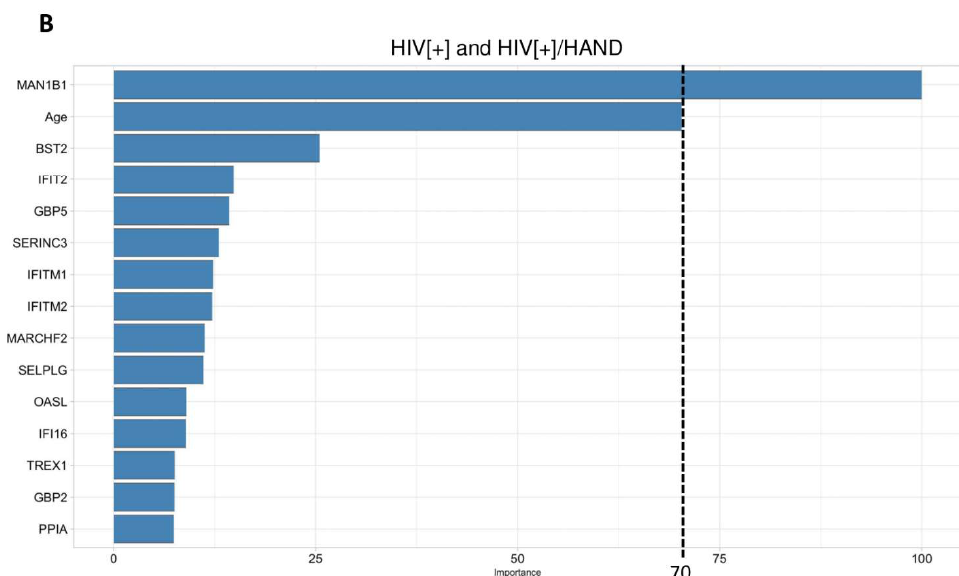
Figure 7. Analyses of variables predicting clinical group classification by machine learning. The regularized logistic regression machine learning method was used to predict variables that distin- guished the HIV[+] group from the HIV[−] group ( A ). Shrinkage discriminant analysis predicted the variable importance for the HIV[+] and HIV[+]/HAND group classification ( B ). An importance value of 70 was set as a threshold. An importance value between 70 and 100 indicates a heavy reliance of machine learning prediction on a specific variable in classifying and distinguishing the compared groups. (* represents CSF or plasma viral load, and ** represents brain viral load (RNA, DNA or iDNA (integrated DNA).) Host genes were derived from qRT-PCR